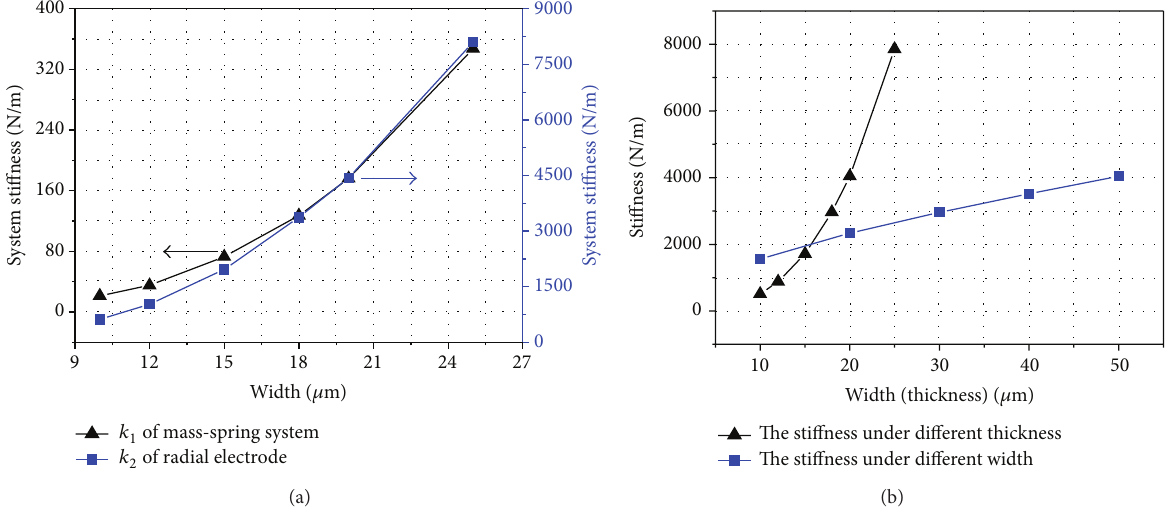
Figure 6: The curve of the stiffness versus the structural parameters: (a) the stiffness of mass-spring system and radial electrode under different spring width and (b) the stiffness of axial electrode under different crossbeam width and